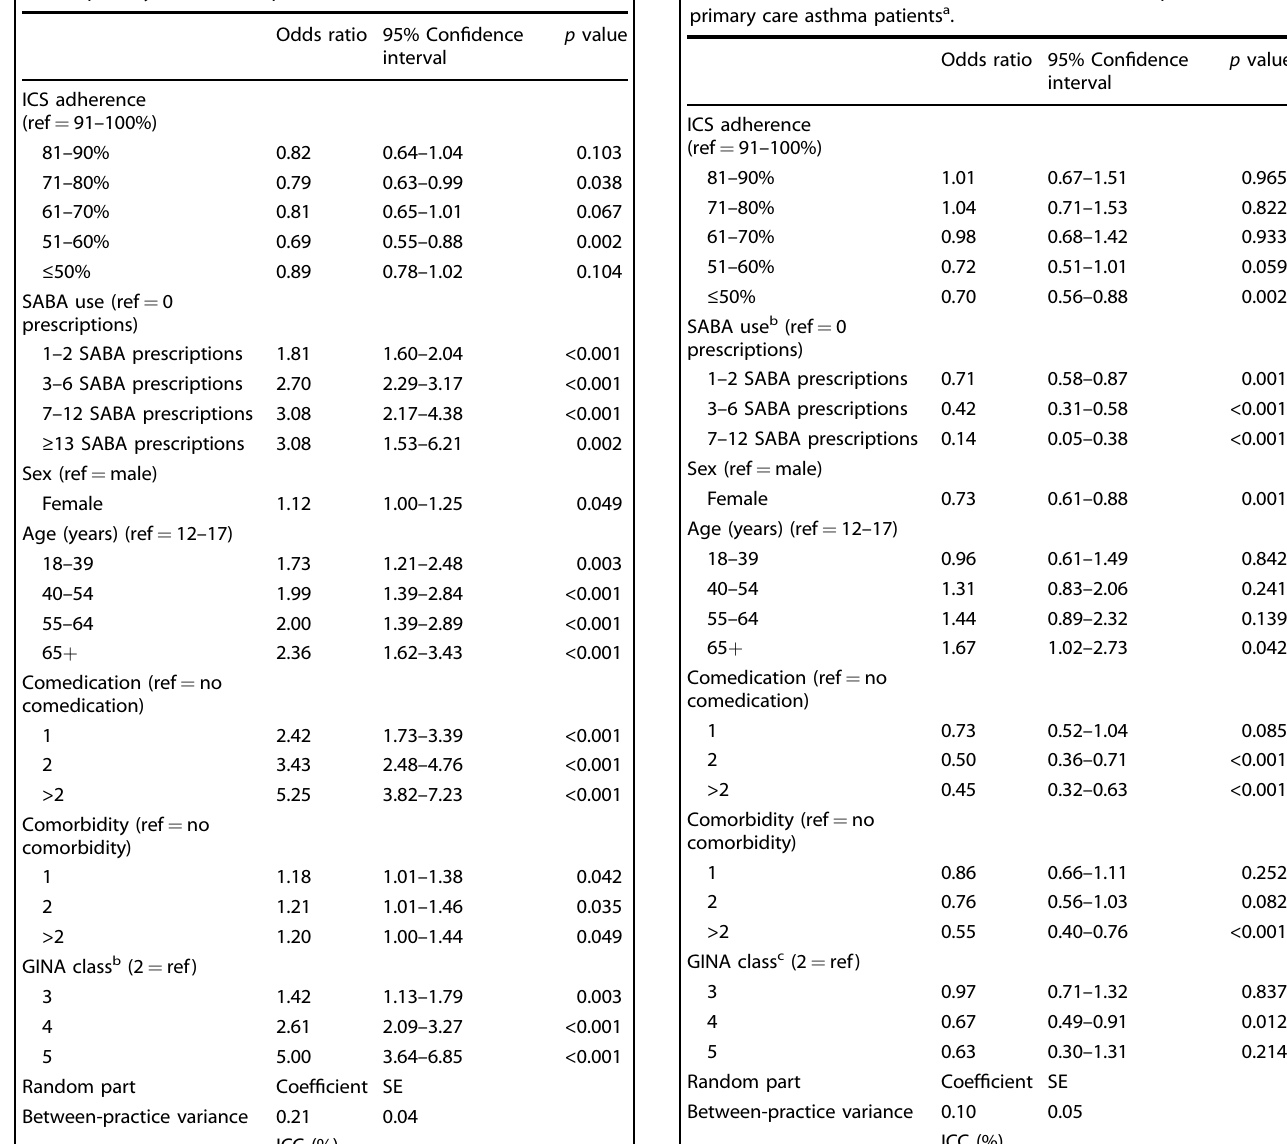
Table 3. Results of multilevel logistic regression analysis in which